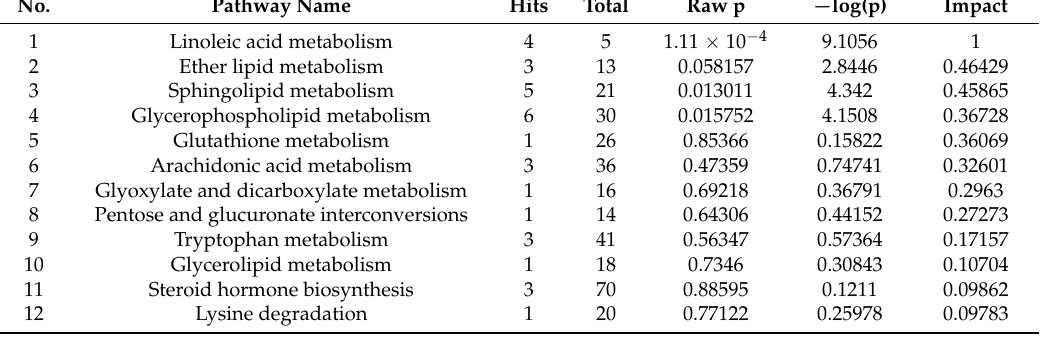
Figure 4. Summary of pathway analysis with MetPA. ( A ) Linoleic acid metabolism; ( B ) sphingolipid